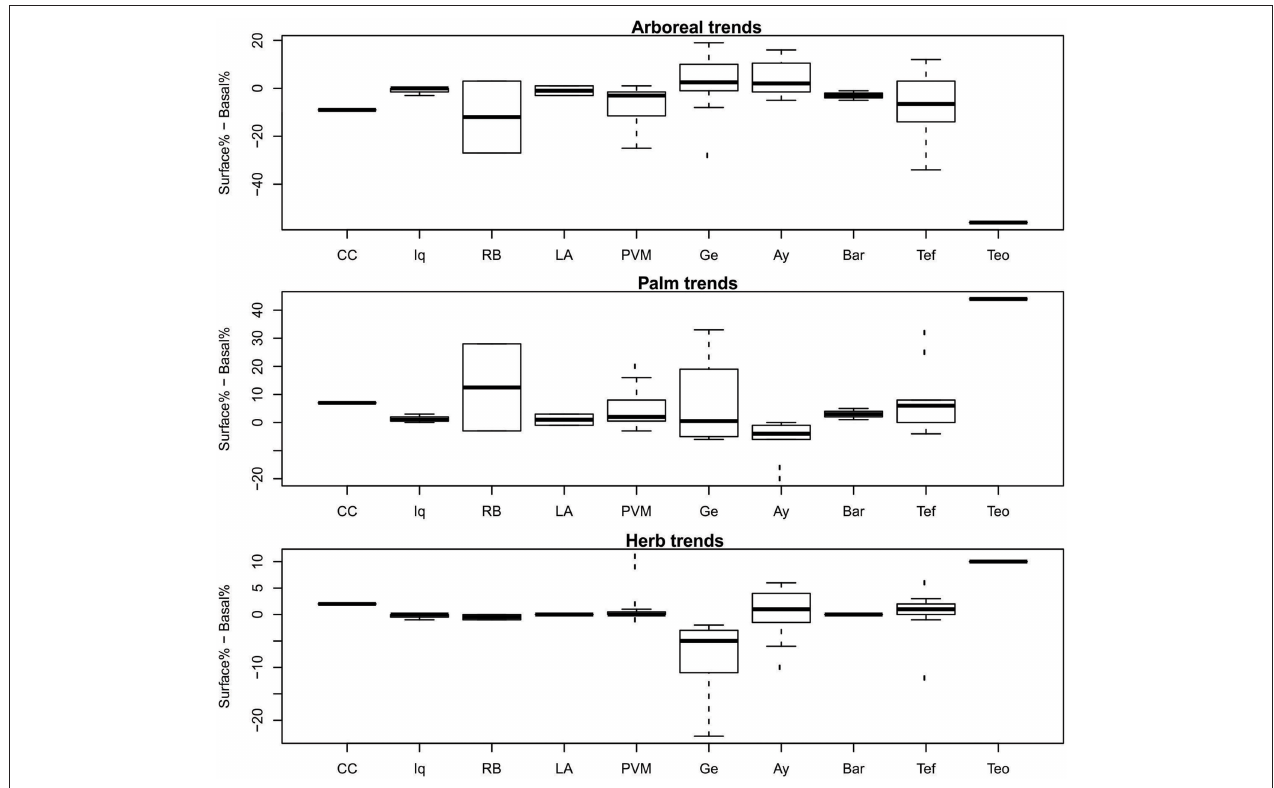
FIGURE 5 | Temporal trends from base to surface of the core. Positive values indicate an increase in those elements through time, negatives values indicate decreases. Regional codes are the same as listed in Figure 3 . See Table 1 for total number of samples analyzed from each region.